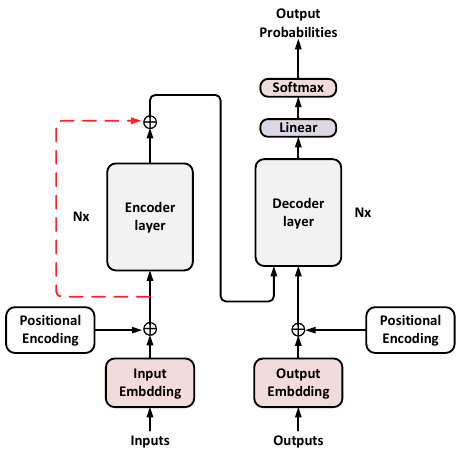
Figure 1. Residual connection structure diagram.